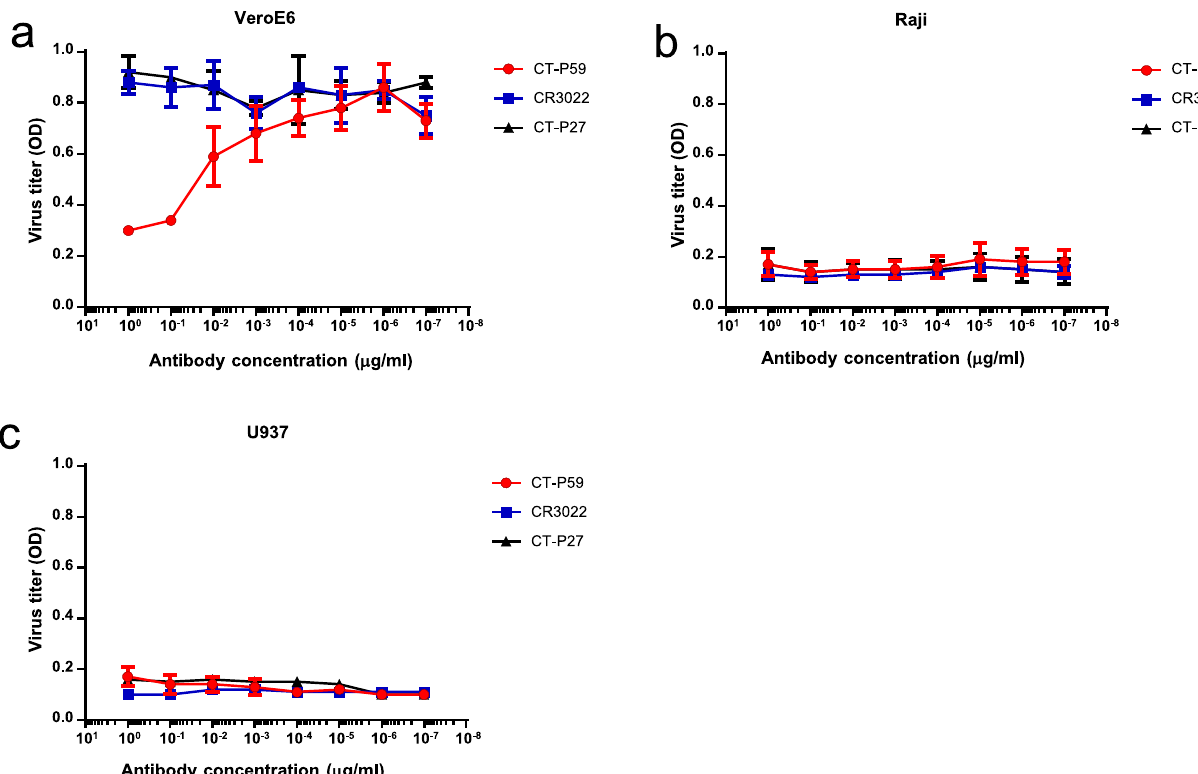
Fig. 5 No evidence of ADE caused by CT-P59 bound to SARS-CoV-2 in permissive cells and Fc receptor (FcR)-bearing cells. a FcR-independent ADE. SARS-CoV-2 was mixed with a wide range of antibodies; CT-P59 (red circle), CR3022 (blue square), and CT-P27 (black triangle). VeroE6 was infected with a virus – antibody complex. The virus titers were determined by optical density (OD) using an anti-nucleocapsid antibody. b Fc γ R II-dependent ADE. In vitro ADE assay was performed as described in ( a ) except Raji cells. c Fc γ R I&II-dependent ADE. In vitro ADE assay was carried out as described in ( a ), except U937 cells. The experiments were performed in triplicates (CR3022 and CT-P27) or in quadruplicates (CT-P59). Average and standard deviation of virus titers are depicted as dot and error bar,